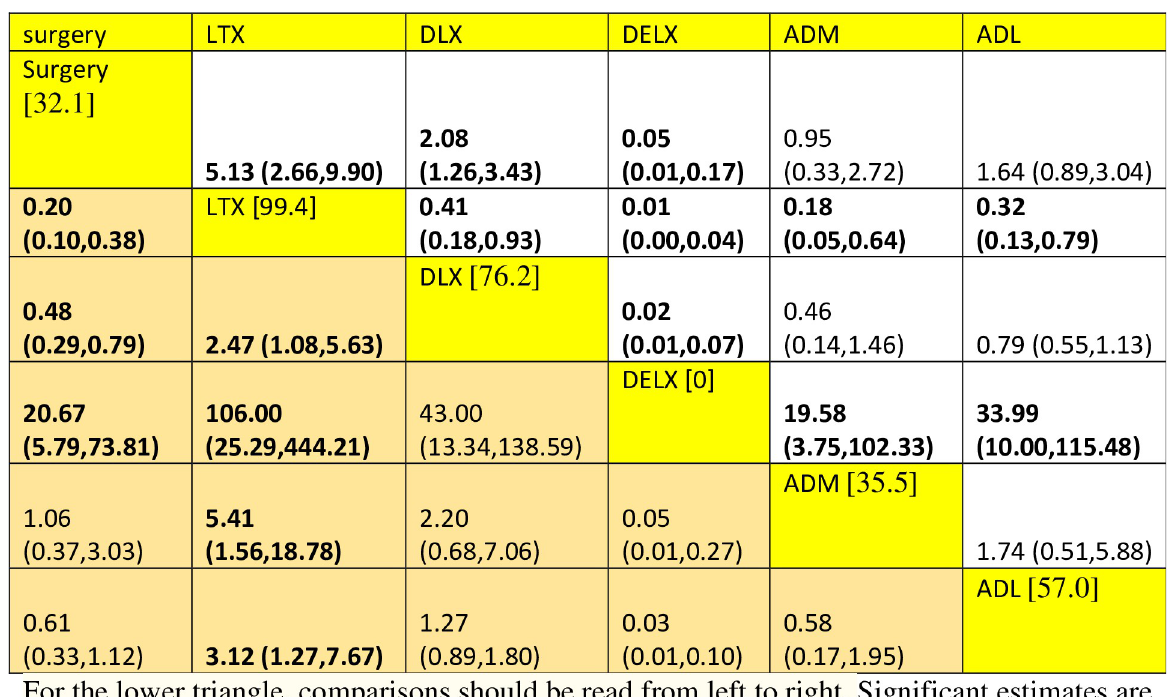
Fig 4. Net league showing the relative Ro resection rate. For the lower triangle, comparisons should be read from left to right. Significant estimates are in bold, as the 95% CI does not overlap zero. OR > 1 means the top-left treatment in better. Parenthesis indicates SUCRA value expressed in percentage. For the upper triangle, comparisons should be read from right to left. OR > 1 means the top-right treatment in better.